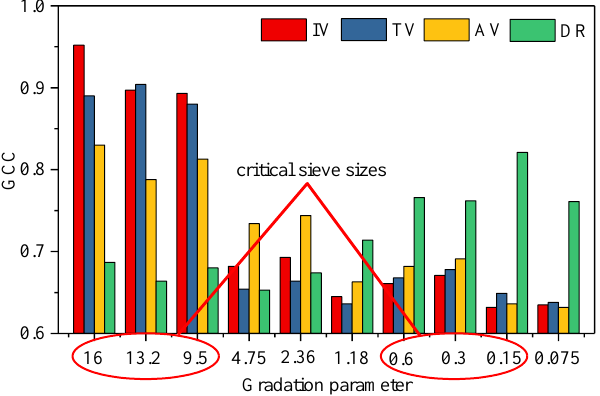
Figure 9. GCC between gradation parameters and skid-resistance indicators.